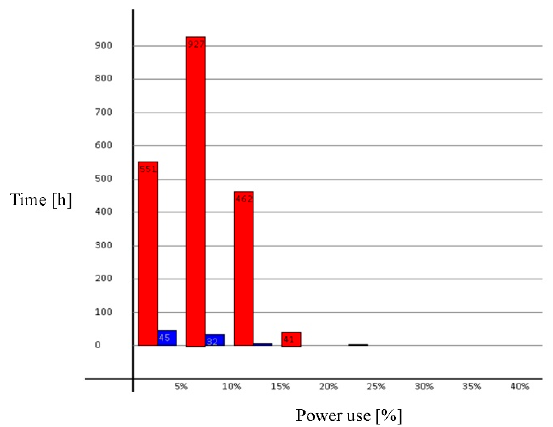
Figure 6. Percentage distribution of the power used for heating and cooling systems in the sleeping area on the first floor.